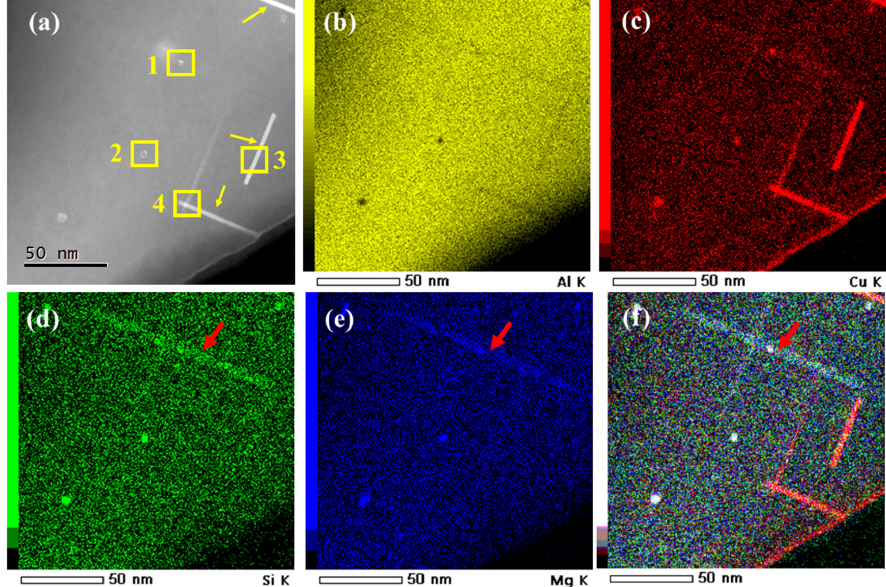
Figure 9. HAADF-STEM images of Al-7%Si-0.3%Mg-0.3%Cr-1.5%Cu alloy ( a ), corresponding EDS maps of elements Al ( b ), Cu ( c ), Si ( d ) and Mg ( e ), and their overlay image ( f ). The atomic-scale HAADF-STEM was applied to further characterize the phases. Fig- ure 10 shows the enlarged areas from the yellow rectangles (marked by 1,2,3,4) in Figure 9a, respectively. By analyzing the atomic-scale HAADF-STEM images in Figure 10a,b, we can see that this is a Q′ phase. The composition of the Q′ phase is Al (cid:2872) Cu (cid:2870) Mg (cid:2876) Si (cid:2875) . It belongs to the hexagonal system, the space group is P-6, and the lattice parameters are a = 1.03 nm and b = 0.403 nm. The Q′ phase has a structure similar to that of the B′ phase. In addition, it can be seen from the figure that there is a triangular substructure in the precipitate, as shown in the yellow triangle in Figure 10a,b. The Cu atom occupies the center of the Mg triangle. This substructure is composed of Mg, Si, and Cu atoms, with Cu atoms as the center and Mg atoms as the framework. Therefore, it can be concluded that the alloy in- deed enters the overaging stage. Thus, it is concluded that the addition of Cu inhibits the transformation from the β (cid:4595) phase to the β′ phase and promotes the transformation from the β (cid:4595) phase to the Q′ phase. The Q′ phase structure model shows that Si is arranged in the quadrilateral frame and that Cu atoms are in the interior of the Si frame. It can be inferred that the Cu atom promotes the structural transformation centered on it. In addi- tion, the Cu atom still tends to be enriched at the interface between the Q′ phase and the matrix, as shown in Figure 10a,b.